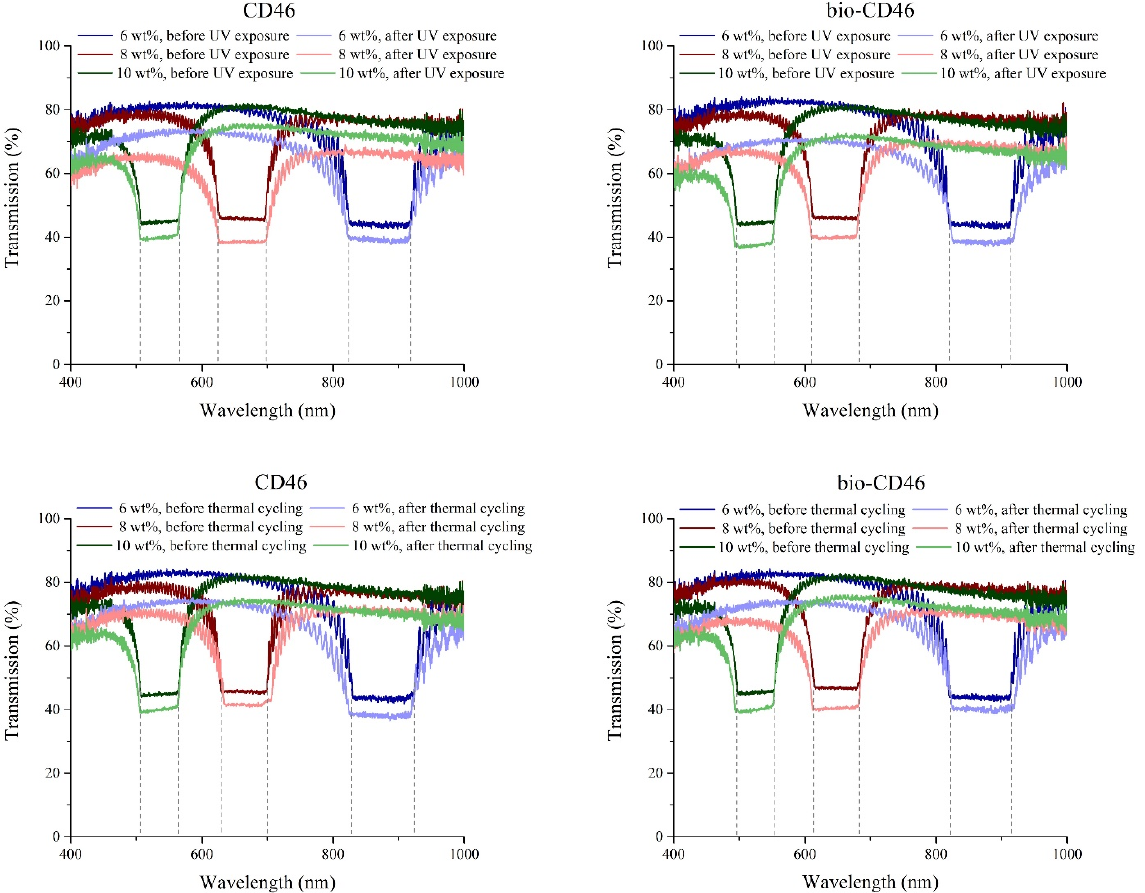
Figure 7. Transmission spectra for CD46 and bio-CD46 in E7 host ( top ) before and after UV exposure for 15 h and ( bottom ) before and after thermal cycling for 24 h. There was no significant evidence of any change, indicating stability of the samples against UV and thermal degradation. Small deviations are caused by defect density.